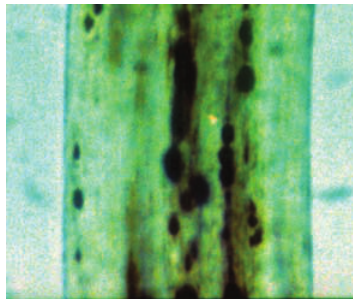
Figure 5 - CHS: hair under polarized light microscopy, bright shafts of different colors (x40).